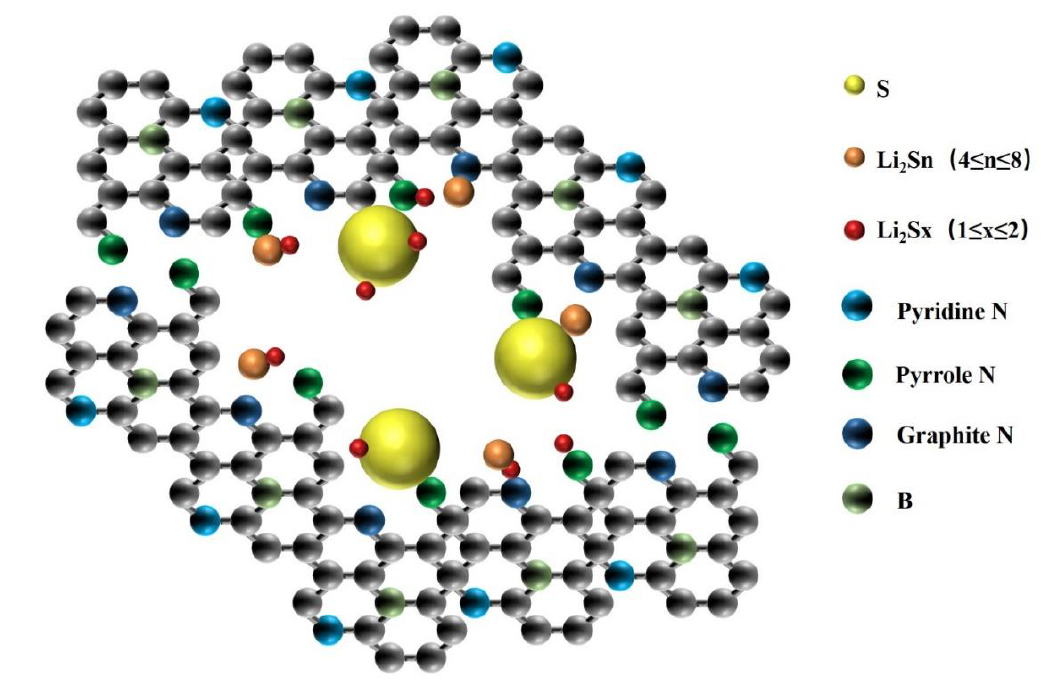
Figure 6. Illustrations of the anchoring effect of BN-reconfigured polarized surfaces on polysulfide species.